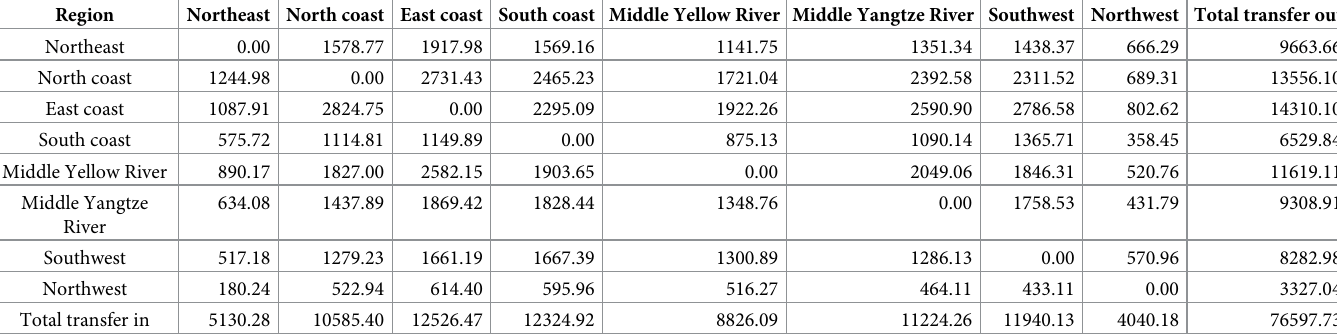
Table 4. Value-added trade among eight regions in China in 2015 (unit: billion yuan). Region